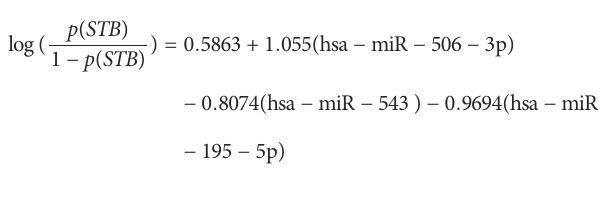
TABLE 2 Signi fi cantly changed 13 miRNA biomarker